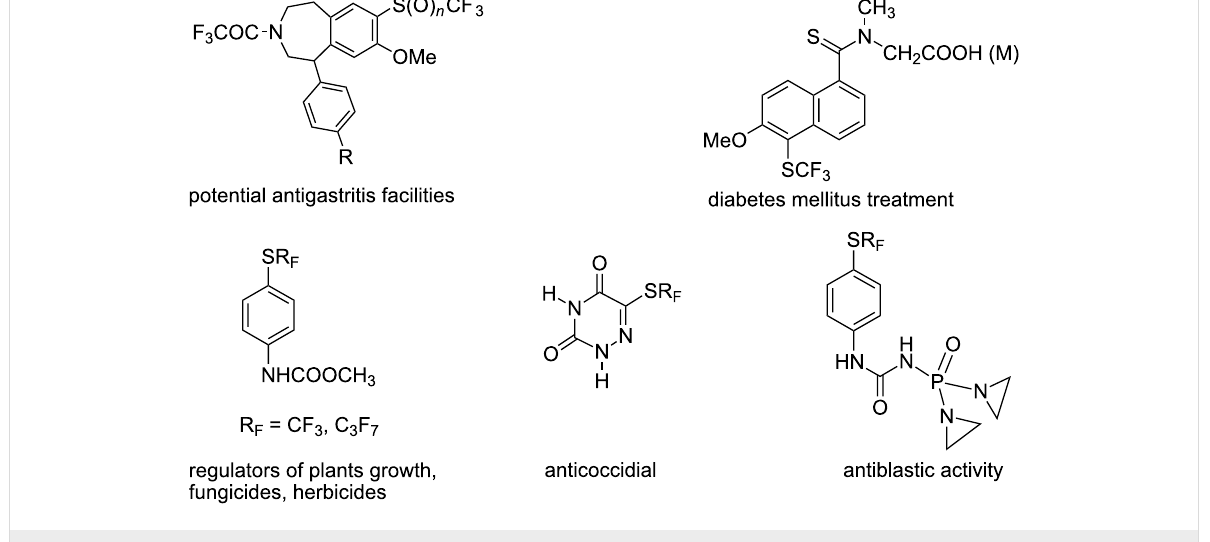
Figure 4: The variety of the pharmacological activity of R F S-substituted compounds.